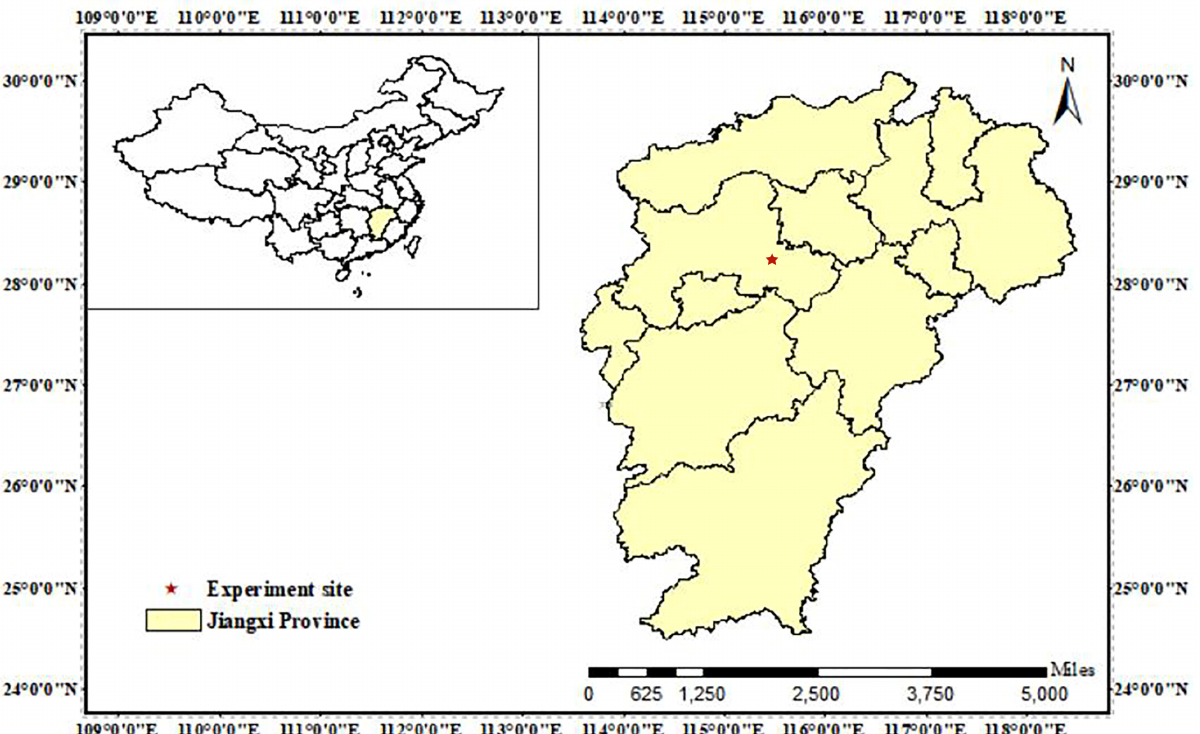
D 2 : Basal fertilizer: Tiller fertilizer: Spike fertilize = 5:3:2; D 3 : Basal fertilizer: Tiller fertilizer: Spike fertilize = 6:3:1), a total of 12 treatments using completely randomized trials are detailed in Table